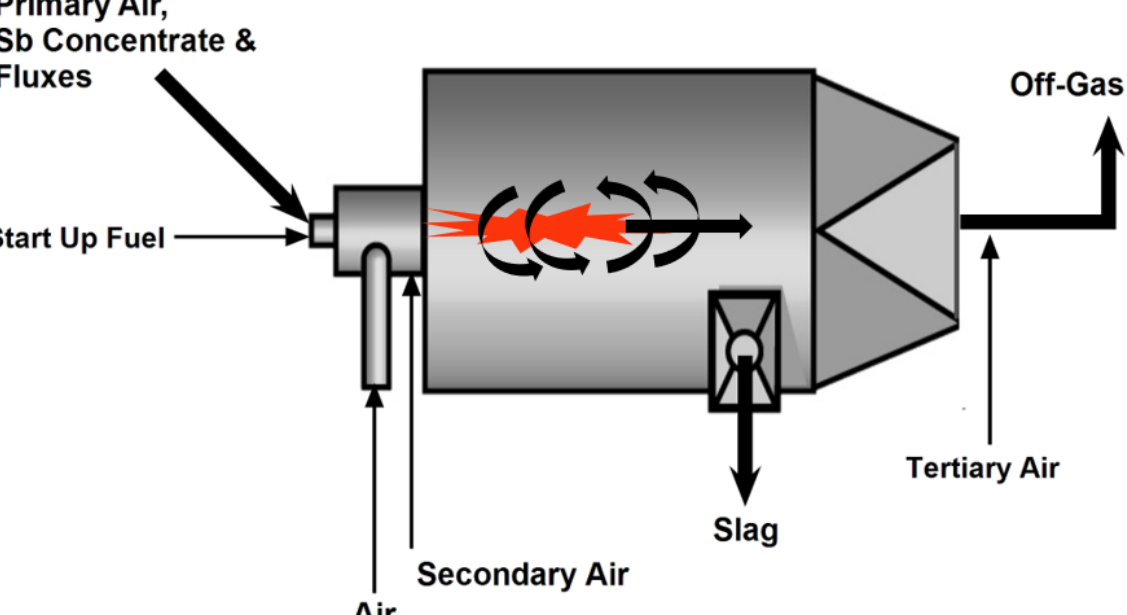
Figure 8. Schematic of typical cyclone